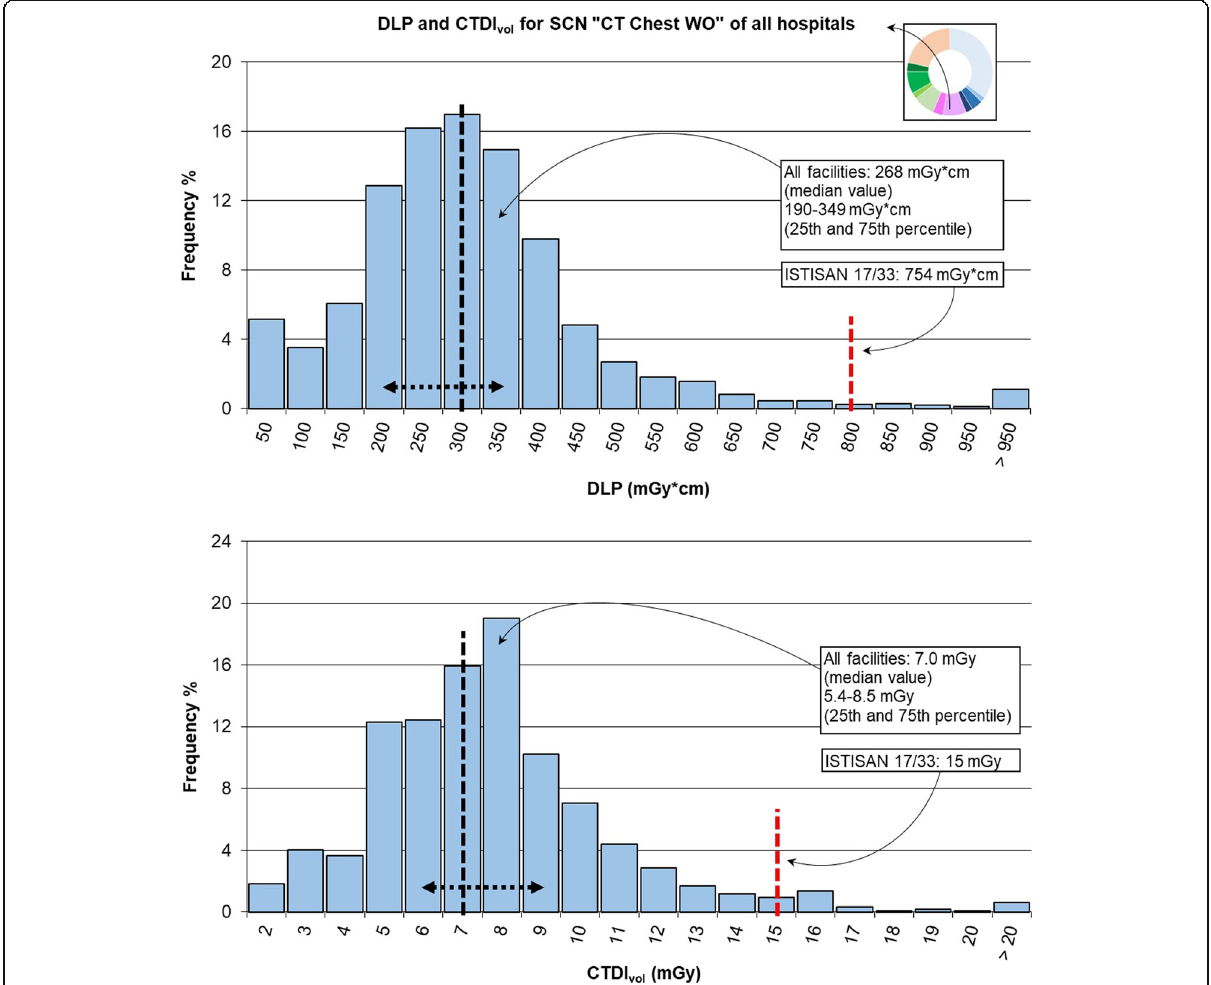
Fig. 5 Distribution of total dose-length product (DLP) and volumetric computed tomography dose index (CTDIvol) for study common name (SCN) “ CT Chest WO ” and comparison with values from ISTISAN 17/33 [18]. The median value and range between 25th and 75th percentile are shown in black dashed lines; the red dashed line reports the diagnostic reference level (DRL) provided by ISTISAN 17/33 [18] Table 3 Dose-length product (DLP) and volumetric computed tomography dose index (CTDI vol ) for the study common name “ CT Abd/Pelv WO ” : data from individual hospitals, total and reference values Number of exams/ number of